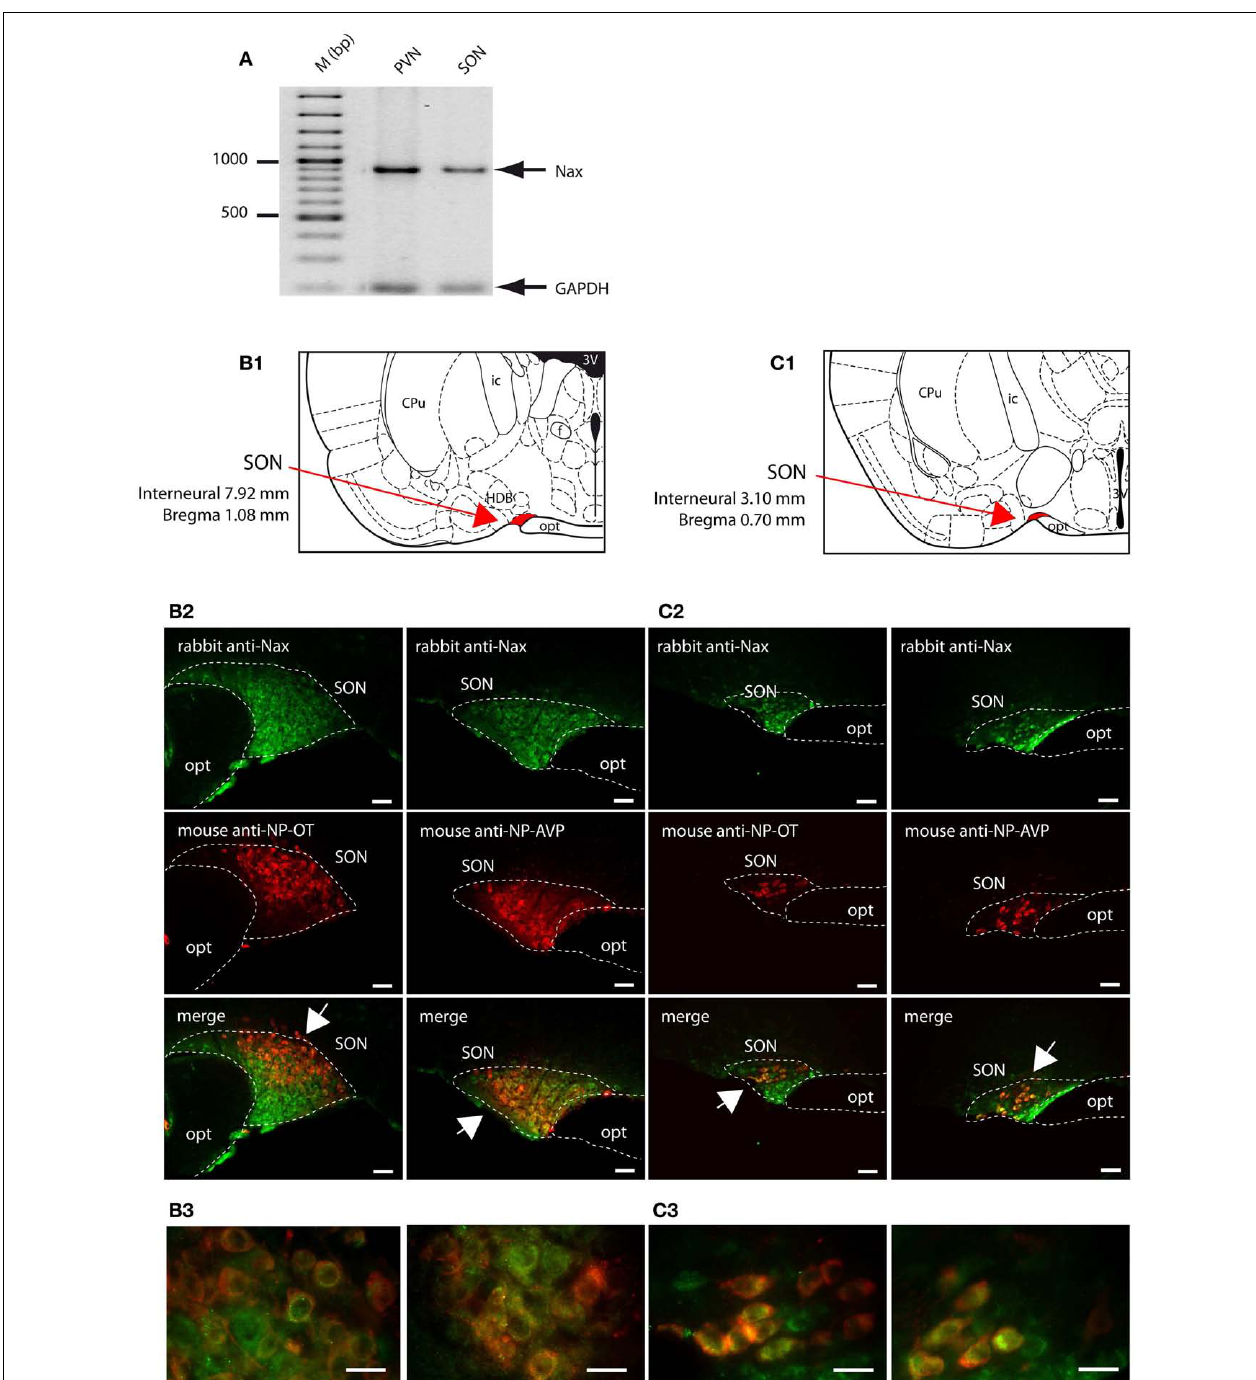
from the rat (B2) and mouse (C2) .The neurochemical content of the cells expressing Na X was identified with the anti-oxytocin neurophysin and the anti-vasopressin neurophysin fluorescent immunostaining (red); scale bars: 50 µ m.The arrow head points the top-right or the bottom-left corner of the inset, which represents a high magnification zone of the rat SON (B3) and the mouse SON (C3) ; scale bar: 20 µ m. Not that Na X immunostaining was present in both vasopressinergic and oxytocinergic magnocellular cells in the rat and